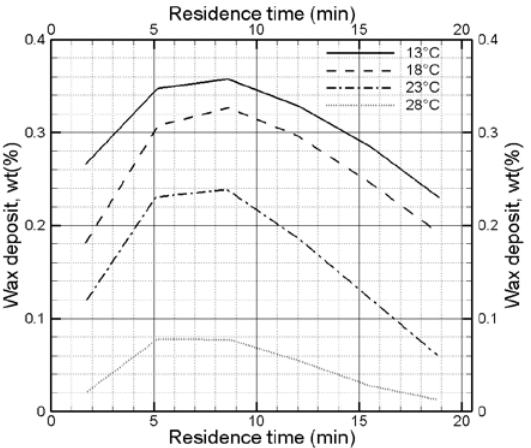
Figure 15 Effect on wax deposition due to residence time at 300 ml/min (Kelechukwu et al., 2010)